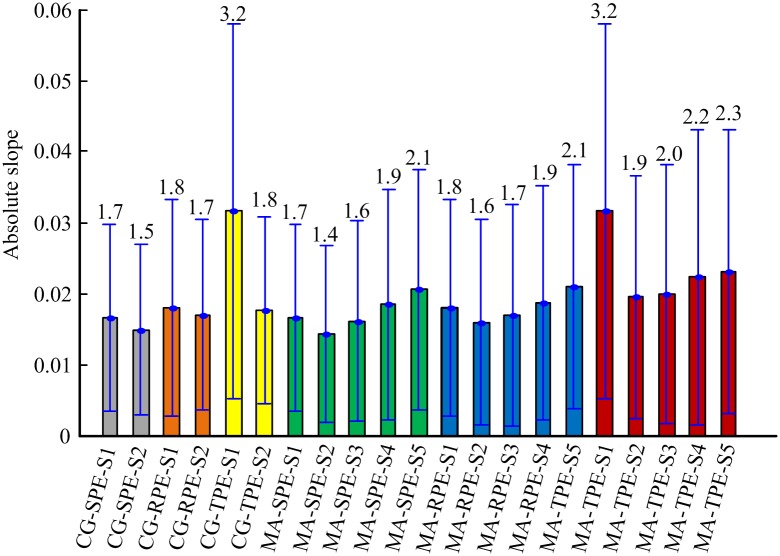
Statistical analysis of the absolute slope for six MSPE indexes at five scales.The numbers represent the mean values of absolute slope (*100) for each measure. The bar height indicates the mean value, and the lower and upper lines are the standard deviation of the measures.